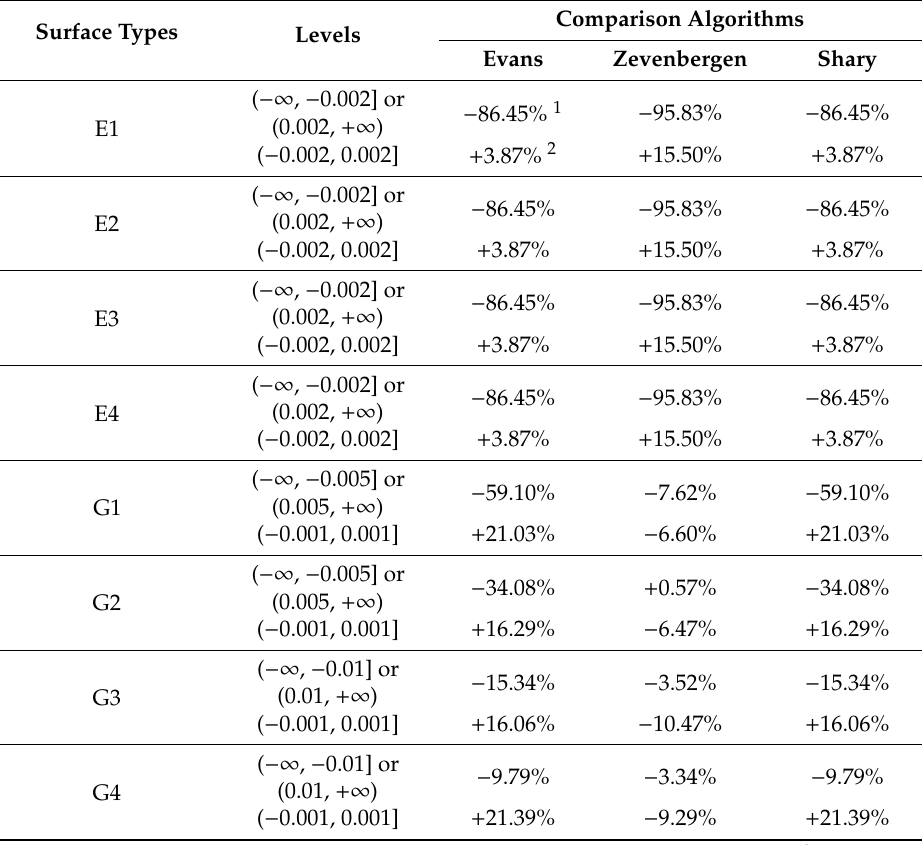
Table 8. Change of the proportion of the large and small errors for the new algorithm on E1, E2, E3, E4, G1, G2, G3, and